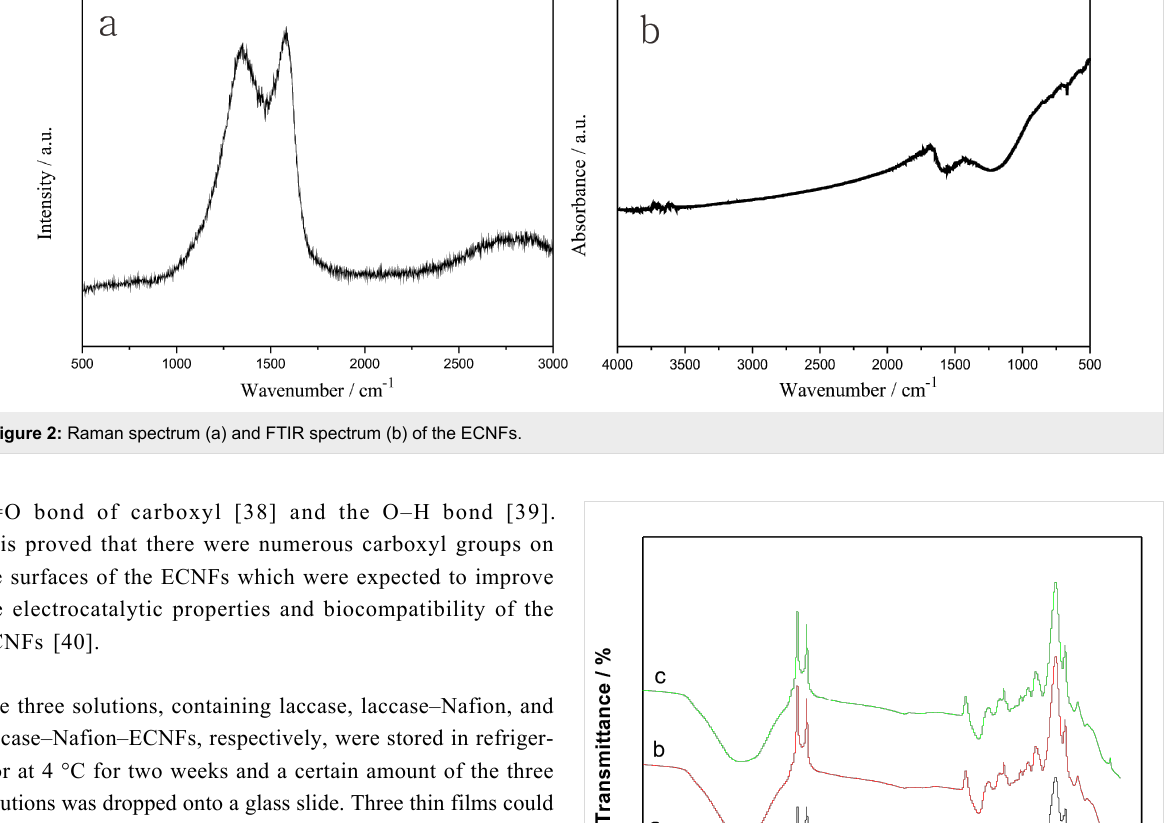
scan rates from 0.05 to 0.3 V·s − 1 . It can be clearly seen that a pair of stable and well-defined quasi-reversible anodic and cathodic peaks occur, which can be attributed to the direct elec- tron transfer between the laccase and the GCE. Besides, the anodic peak currents were larger than the peak cathodic currents, indicating a quasi-reversible electrochemical reaction process. Simultaneously, both of the currents increased with the rise of scan rates, the redox peak potentials shifted slightly with an increase in the distance between anodic peak and cathodic peak. As can be seen from the inset of Figure 4, the currents corresponding to redox peaks grew linearly with the scan rates from 0.05 to 0.3 V·s − 1 . This indicated that the electron transfer occurred easily between the laccase–Nafion–ECNFs composite and the surface of the GC electrode and that the electrochemical activity of the whole process is surface-